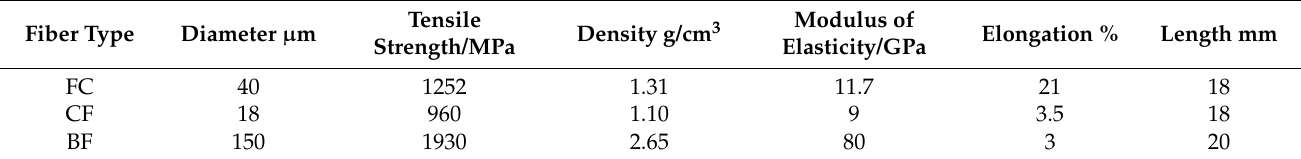
Figure 2. Morphology of the three types of fibers. Table 2. Fiber physical and mechanical properties index.